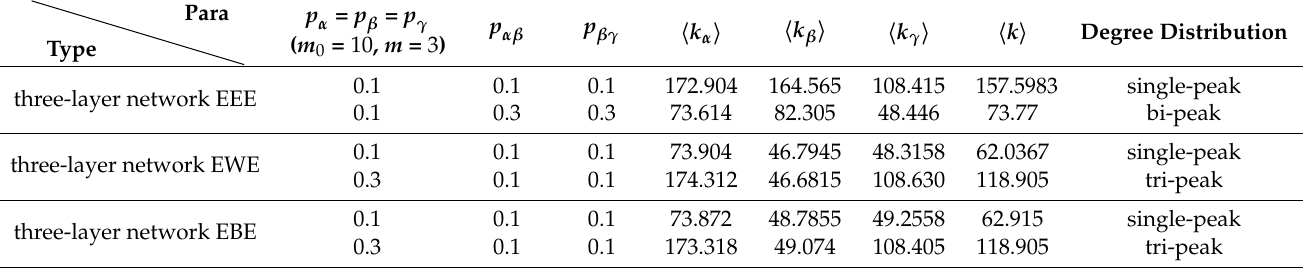
Table 2. The degree distribution characteristics of the three-layer complex